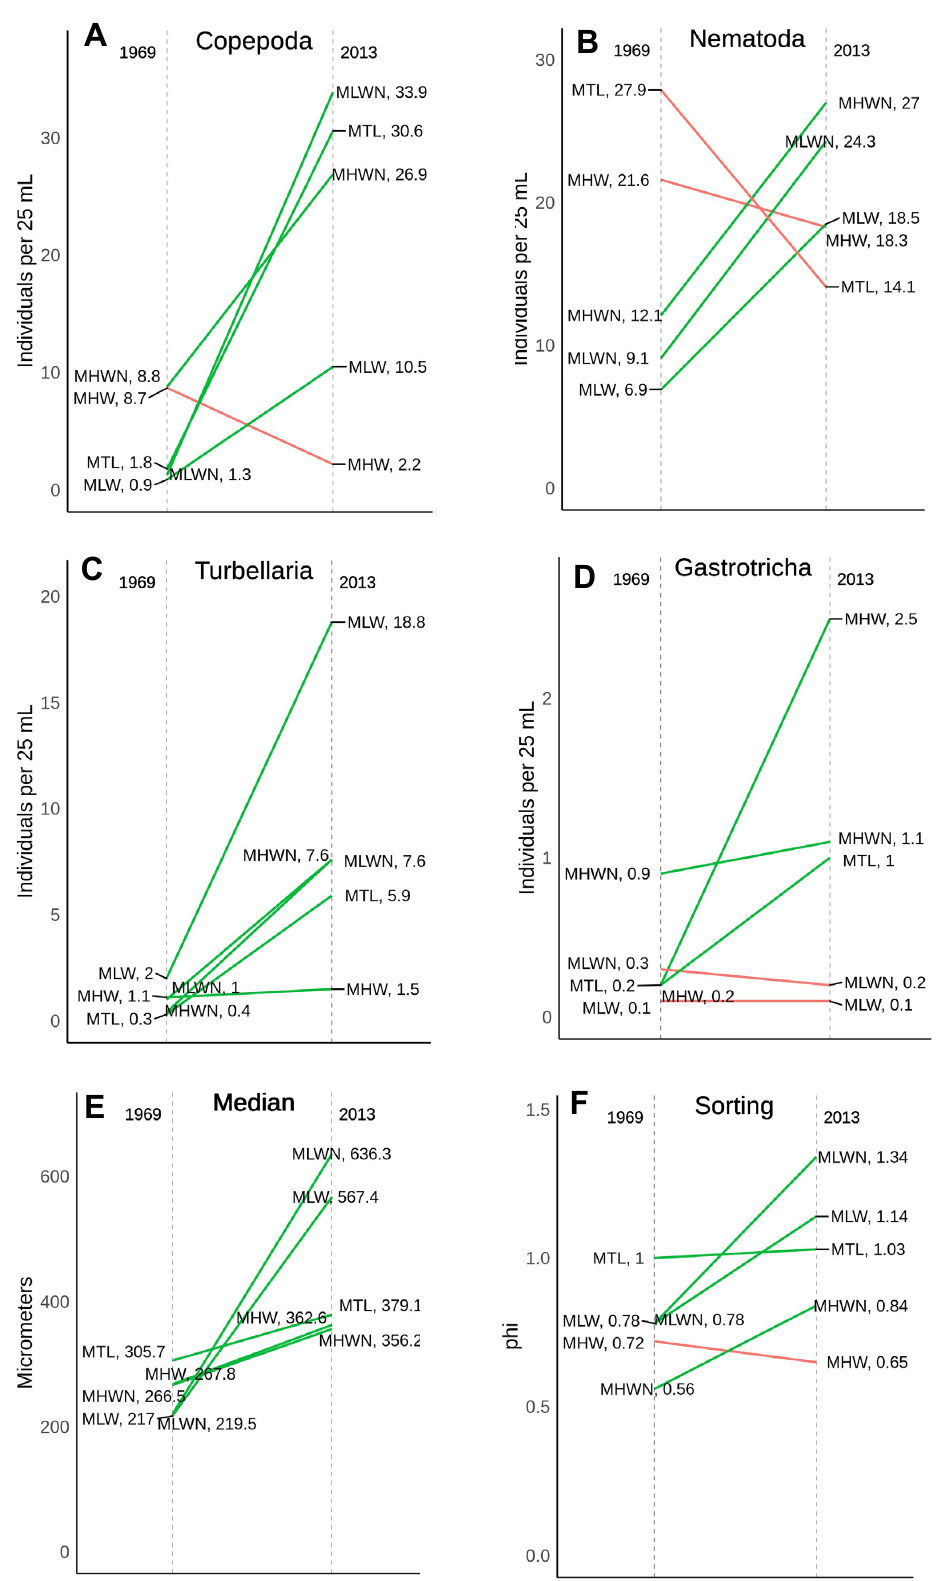
Figure 7. Historical comparison of the more abundant meiofaunal taxa ( A – D ) and grain size parameters ( E,F ) from samples collected in the same Iron Steamer Pier beach locations (tide and depth) in 1969 and 2013. Colors and tidal height abbreviations as in Figure 5.